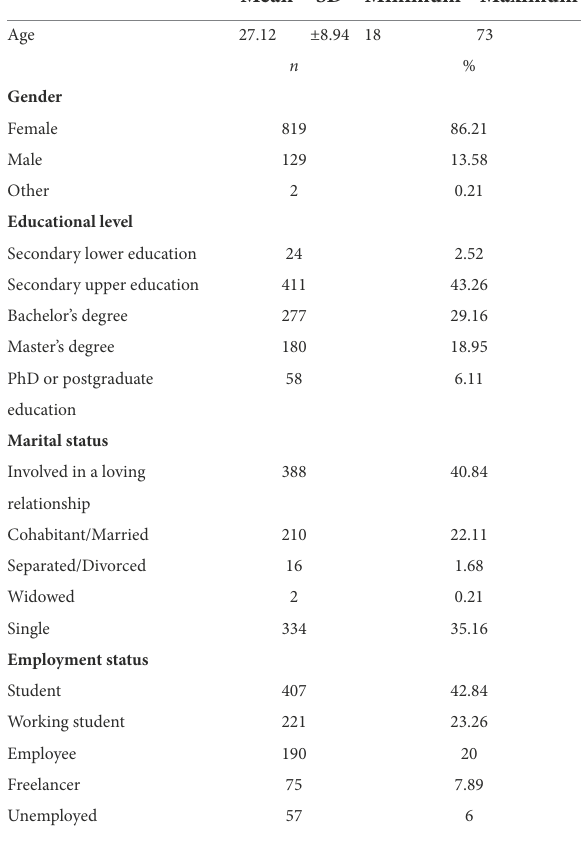
TABLE 1 Socio-demographic characteristics of the